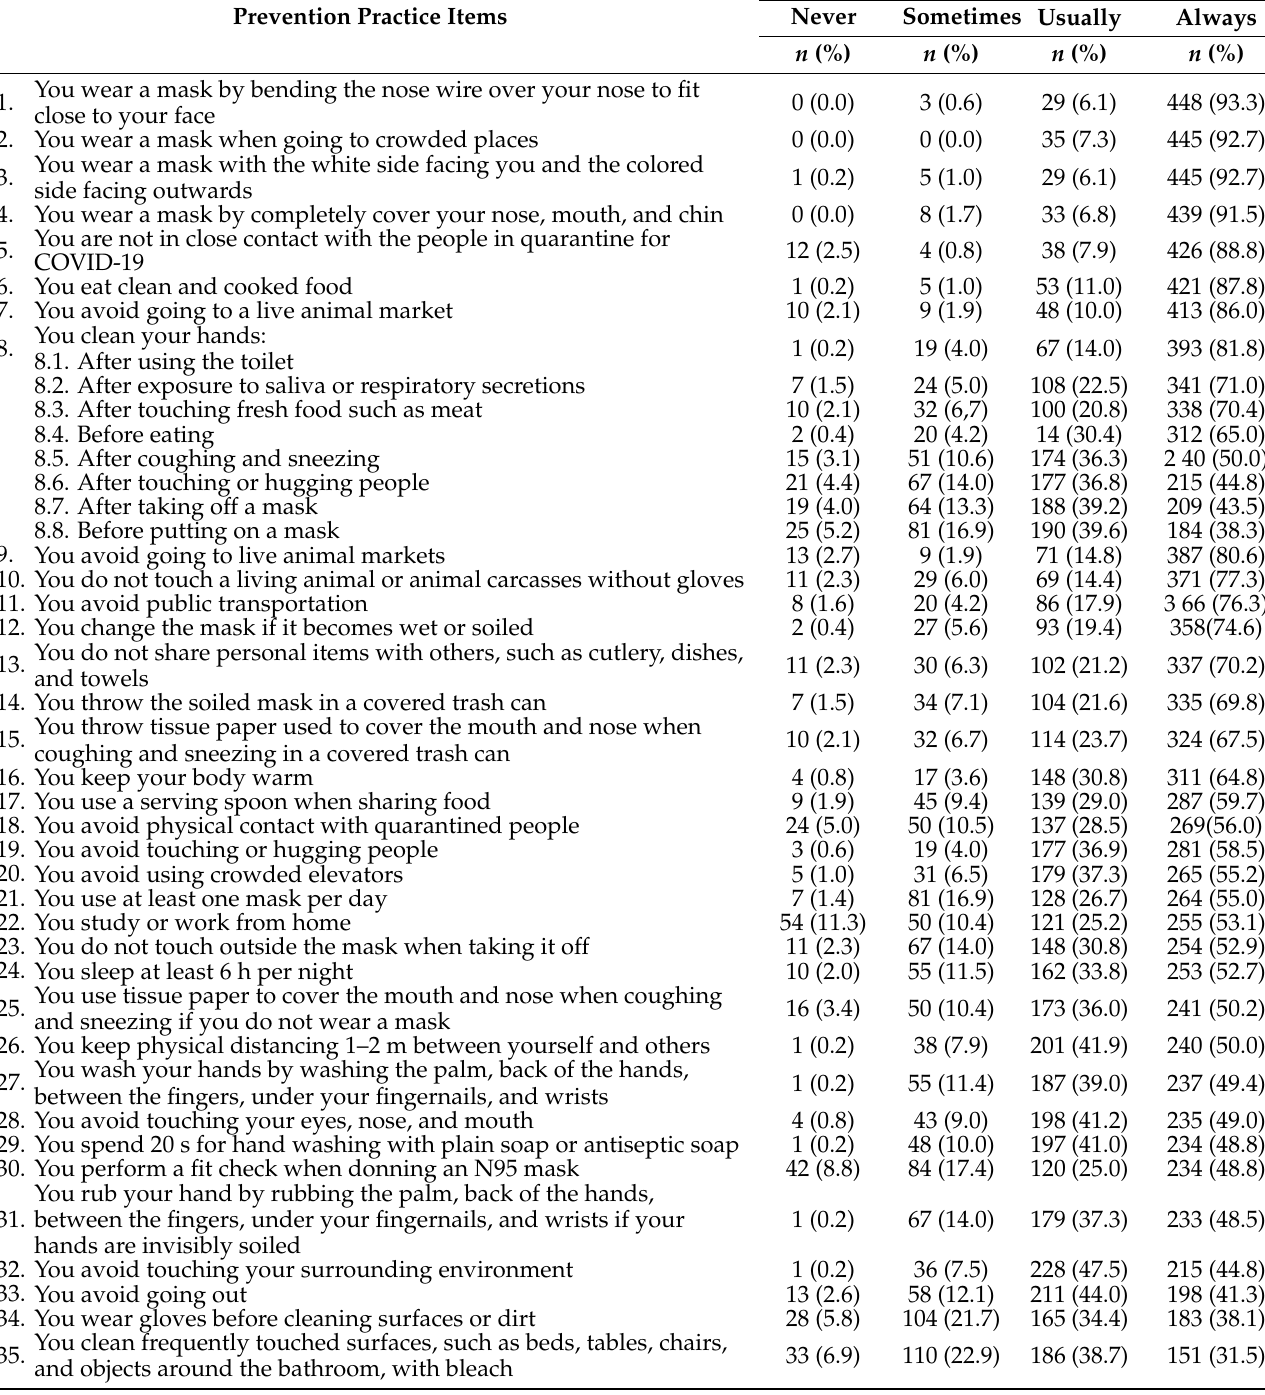
Prevention Practice